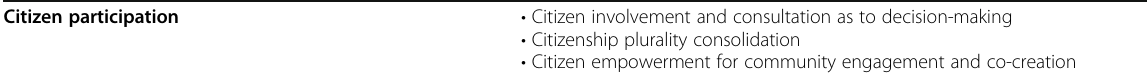
Table 2 The key strategies and solutions of the eco-city district for achieving the three goals of sustainability (Continued) Citizen participation